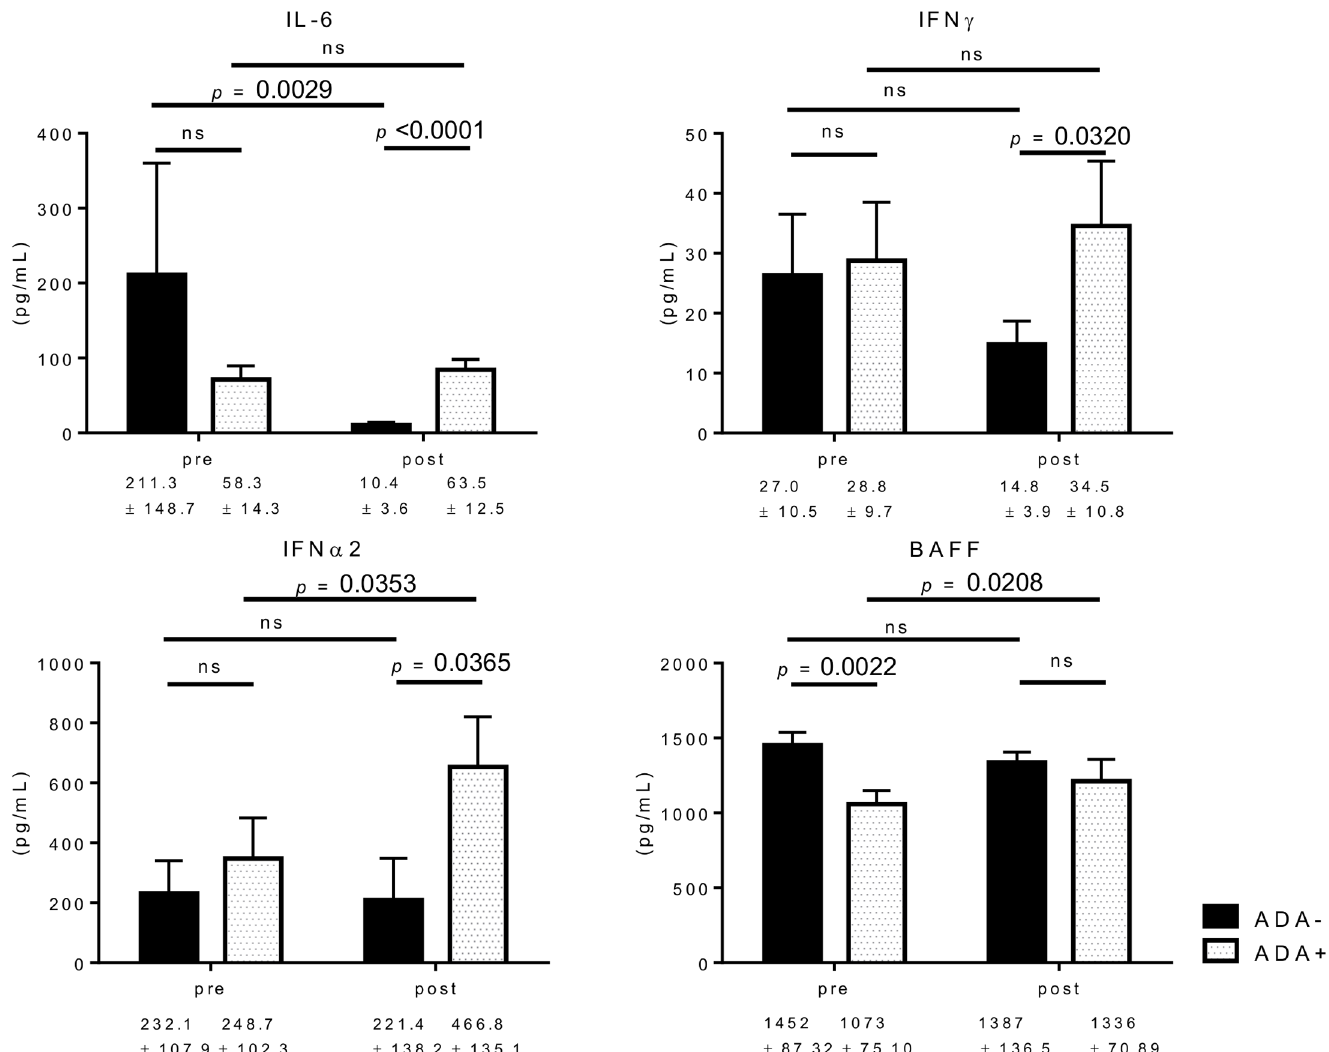
Fig 4. Serum cytokine levels before and 12 months after IFX treatment. The pre- and post-treatment levels of IL-6, IFN- γ , IFN- α 2 and BAFF were compared between ADA-positive (+) and ADA-negative (-) groups. Data are presented as mean + SEM. A paired t -test for intra-group comparison and the Mann-Whitney test for inter-group comparison were